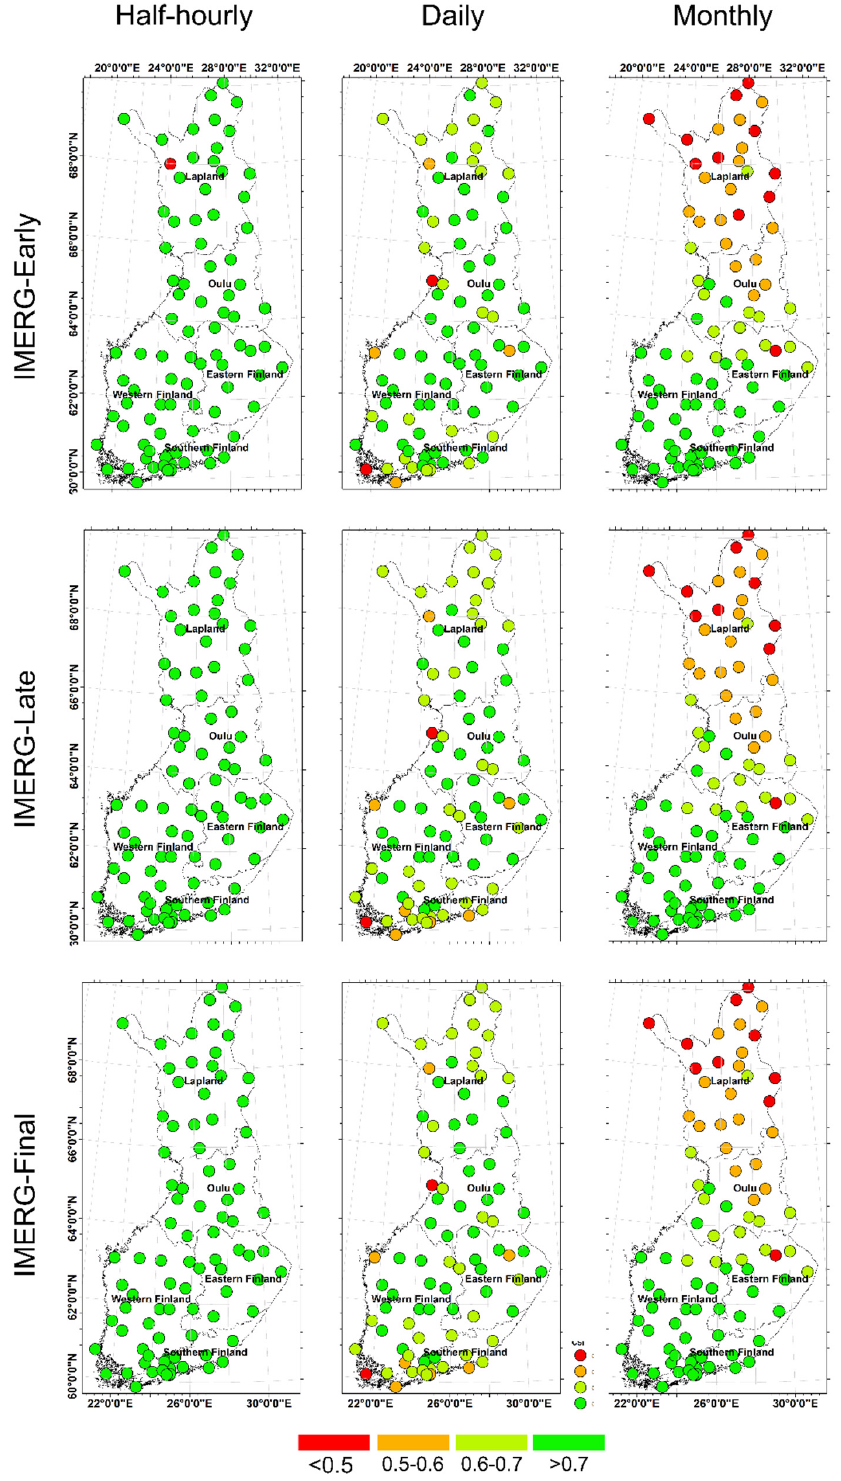
Figure 11. Spatial distributions of the hourly, daily, and monthly CSI for IMERG-Early, IMERG-Late, and IMERG-Final.